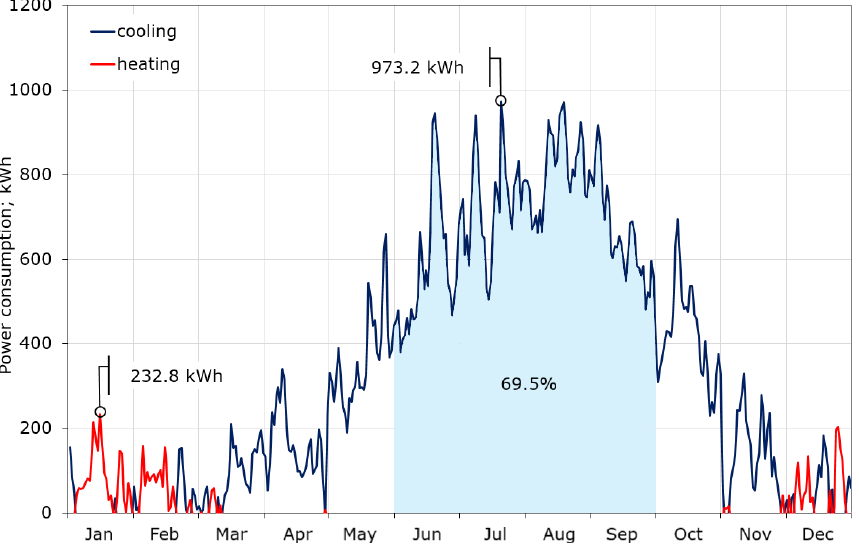
Figure 8. Daily cooling and heating power consumption.